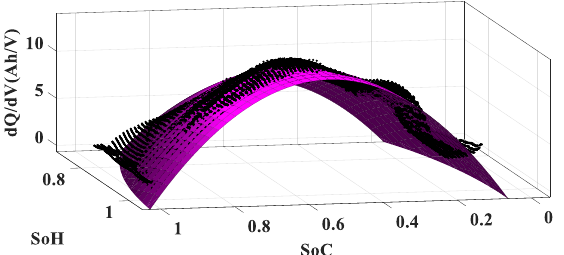
Figure 5. The relationship of SoC, dQ / dV and SoH (the degrees of the 3D fitting surface of the scatter: SoH: 2; SoC: 2).